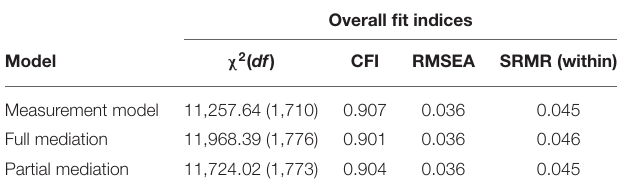
TABLE 2 | Measurement and structural within-level model fit